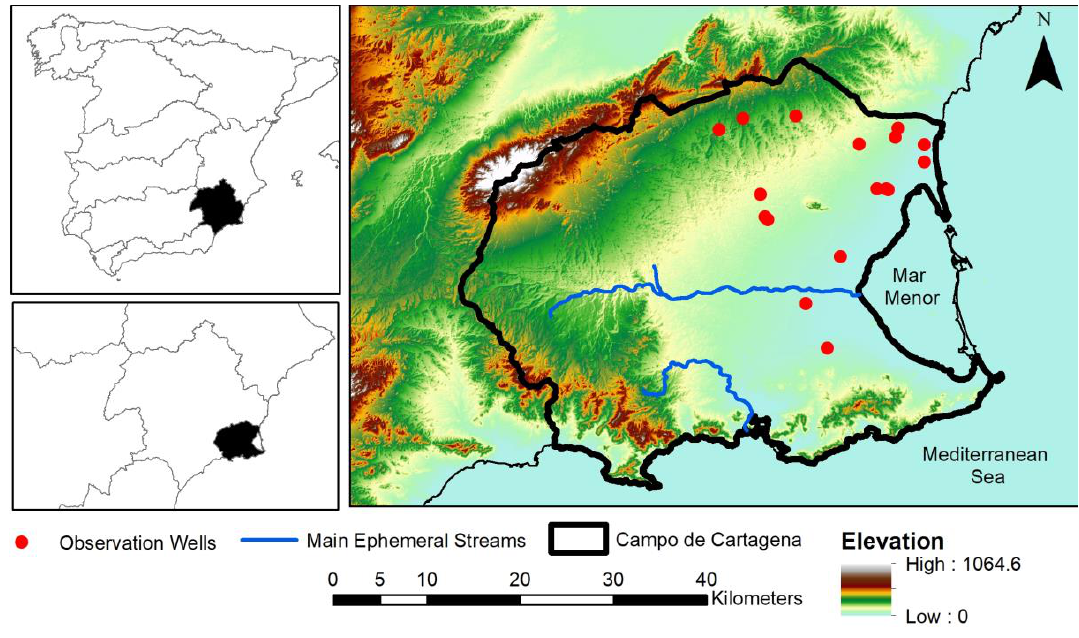
Figure 1. Location of the Campo de Cartagena and its digital elevation model (DEM).